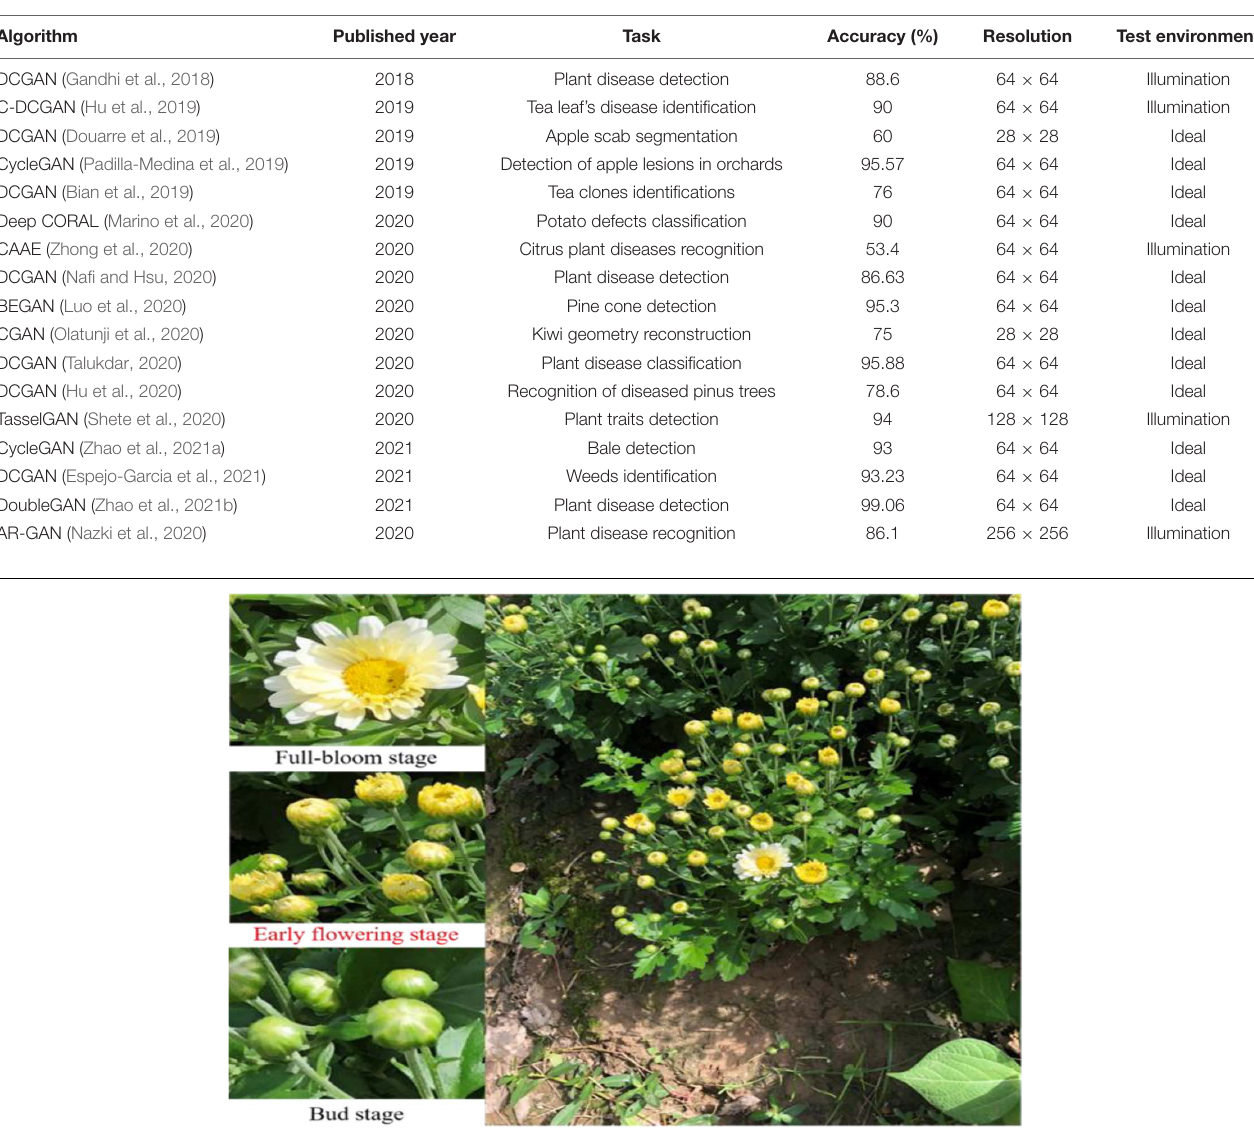
TABLE 2 | Available literature using GAN for image recognition in agriculture. Algorithm